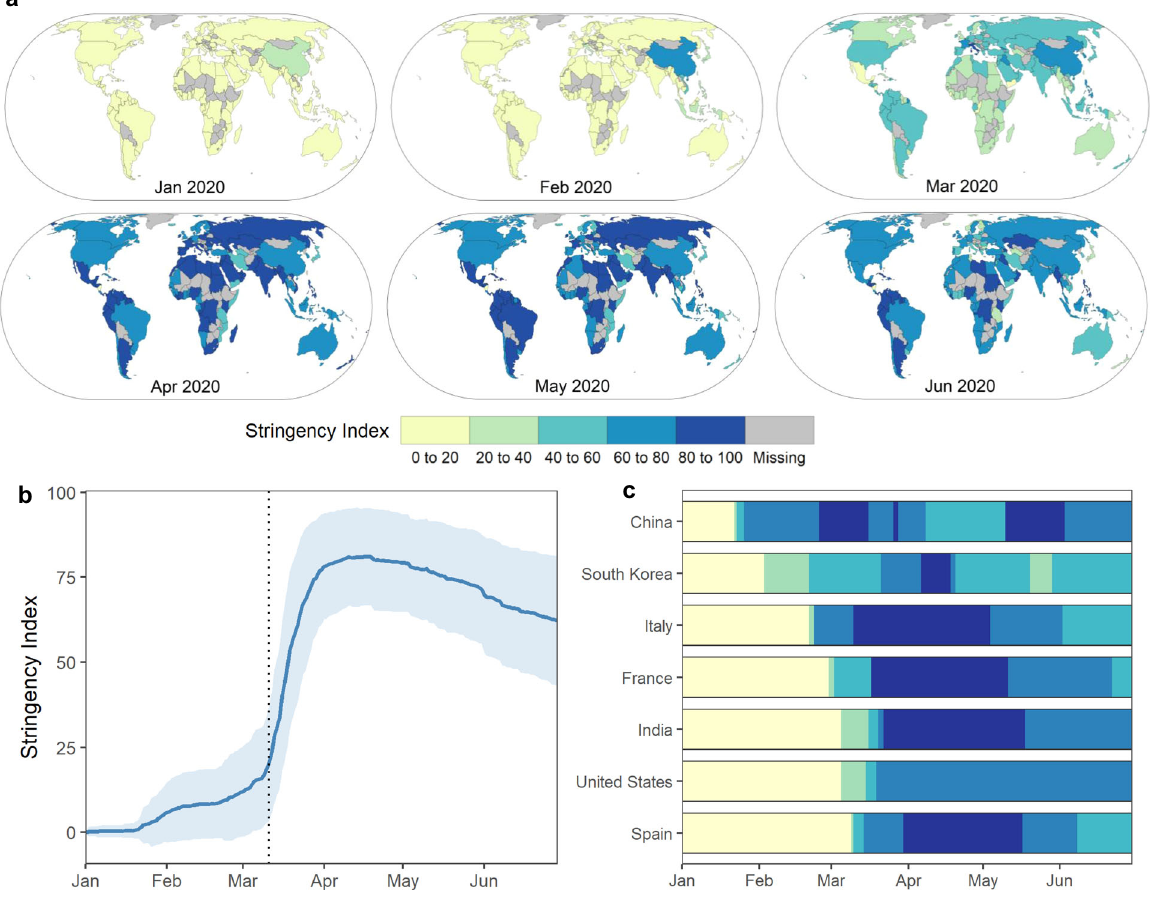
Fig. 1 Spatial and temporal variation of the con fi nement measures in coastal countries during the fi rst half of 2020. We use the Stringency Index (100 = strictest response) as an indicator of con fi nement measures for coastal countries ( n = 124). a Monthly mean per country. b Global daily average and standard deviation from 1 January 2020 until 30 June 2020. Vertical dotted line represents the World Health Organization pandemic declaration on 11 March 2020. c Individual series for selected countries, ordered according to the fi rst date when the Stringency Index was above the fi rst quintile. Note that data were not available for all coastal